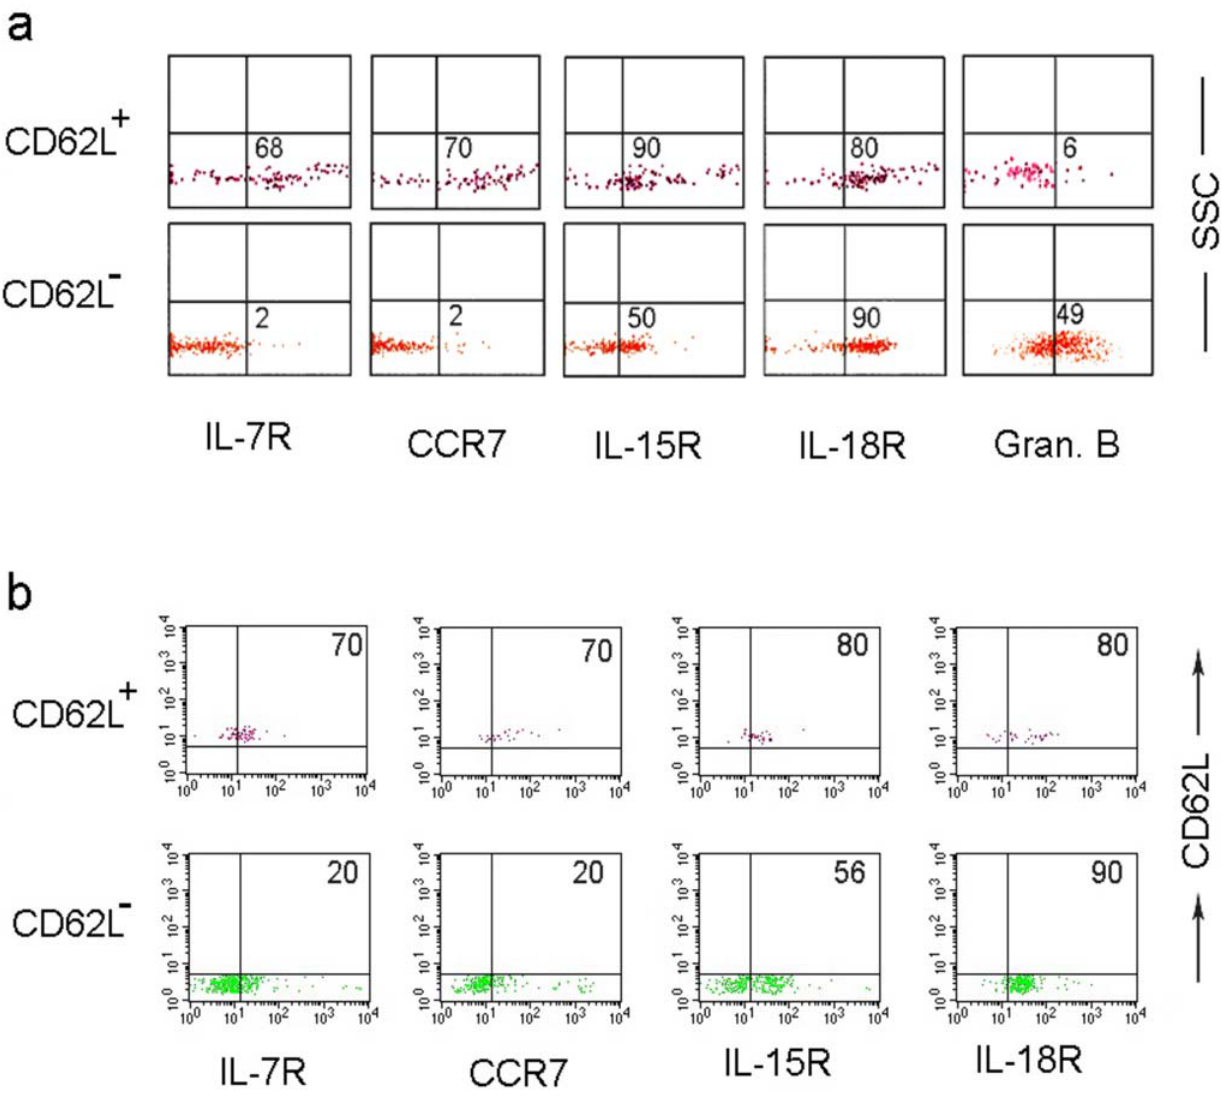
Figure 3. Antigen-specific CD8 + T cells with both effector and central memory phenotype can be detected during an acute infection with vaccinia virus. C57BL/6 mice were i.p. infected with vv and after 7 ( a ) or 5 ( b ) days of infection, the phenotype of CD62L + and CD62L 2 B8R 20– + T cells in the PELs examined by flow cytometry. The indicated marker expression by CD62L + and CD62L 2 B8R + 27 CD8 shown. Results are representative of three independent